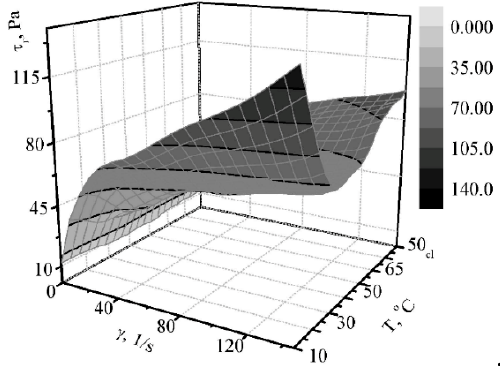
Figure 10. The dependence of the shear rate for the “Yagidka” product on shear rate and time with minimal mechanical treatment.